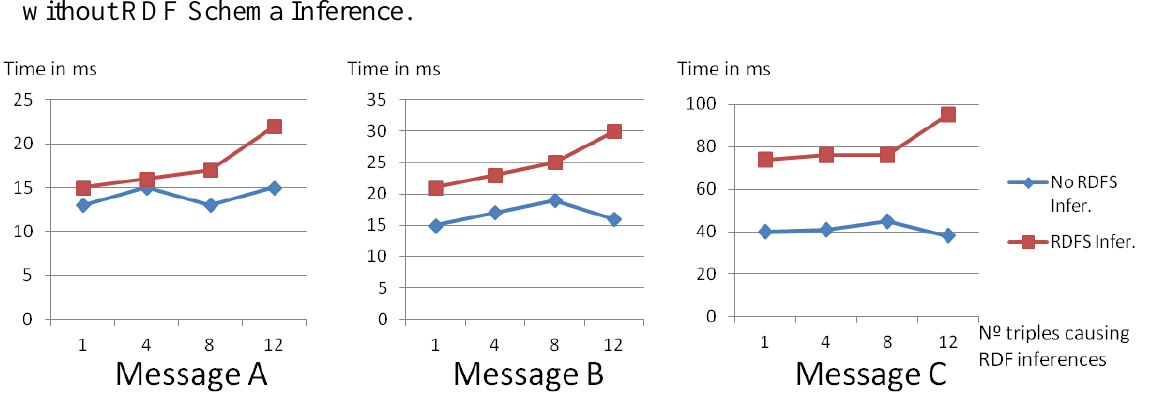
Figure 8. Time required to add different volumes of observations to the repositories with and without RDF Schema inference